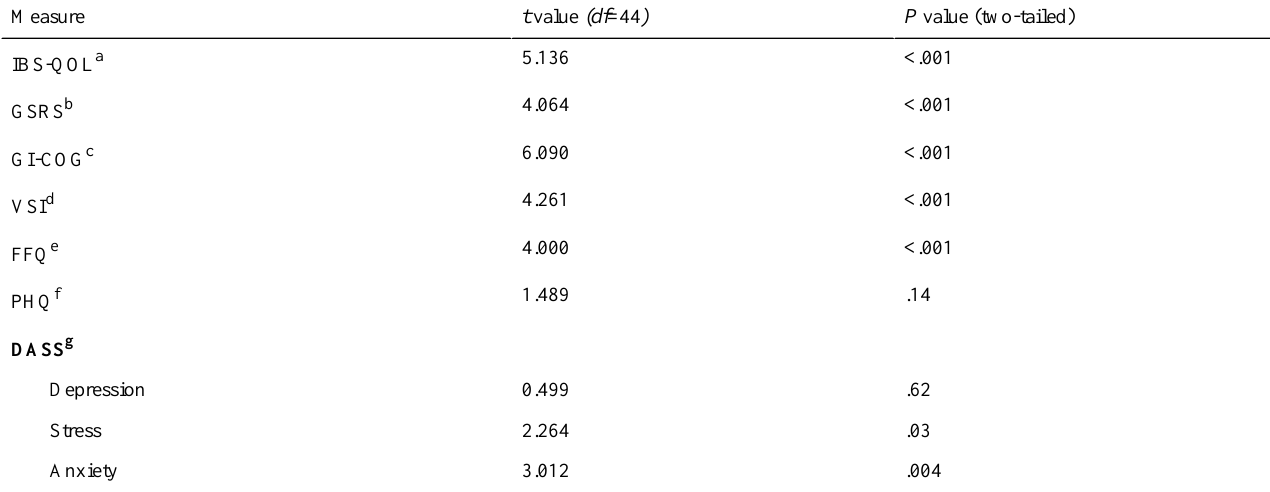
Table 5. Difference between baseline and 3-month follow-up data for all participants